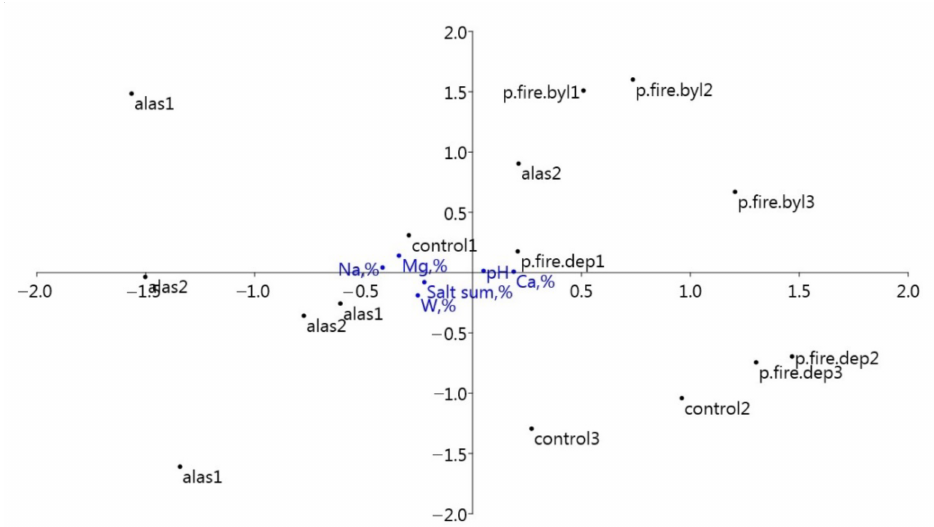
Figure 5. Scatter plot of correspondence analysis of soil properties (Mg, Ca, Na are given as a percentage of the sum of exchange bases—%; pH—acidity; Salt sum—sum of salts%; W—soil moisture%. Samples group: control—soil profile under the intact forest; p.fire.byl—soil profile on the top of byllar; p.fire.dep—soil profile on the depression between byllars; alas—soil profiles inside of alas. The numbers next to the samples groups indicate location of the sample in the profile: 1—upper part of profile, 2—middle part of profile, 3—lower part of